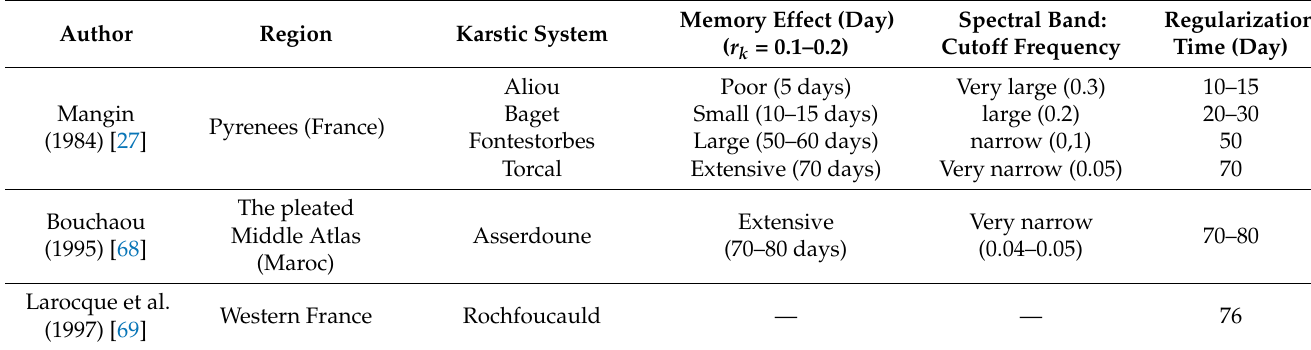
Figure 5. Correlogram of daily rainfall and runoff time series (windows of 125 days).